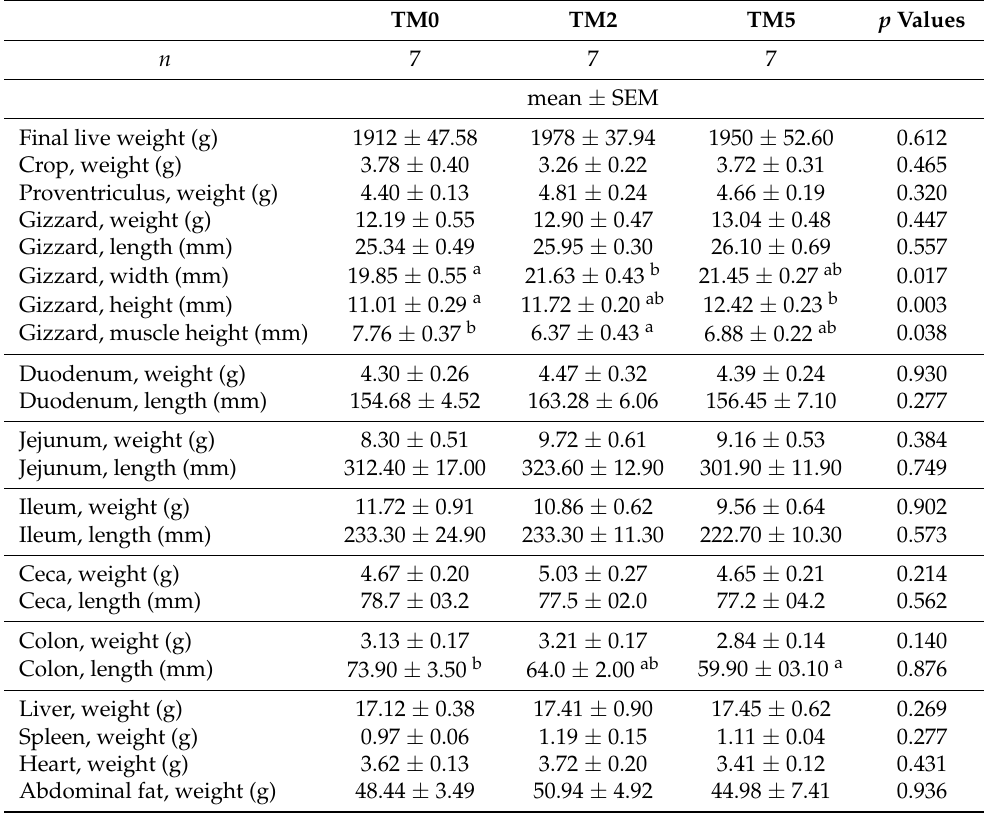
Table 2. Relative sizes of individual sections of the digestive tract of hens (per kg of live weight). TM0 TM2 p